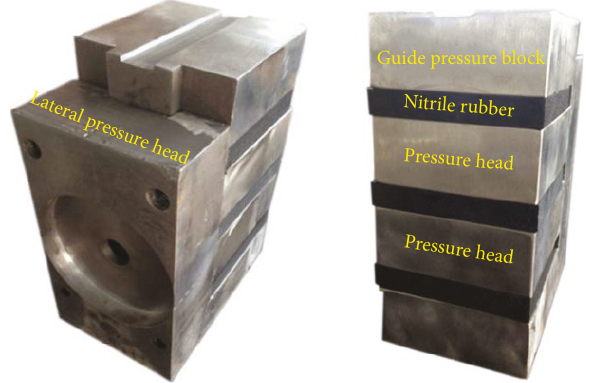
Figure 4: Lateral pressure